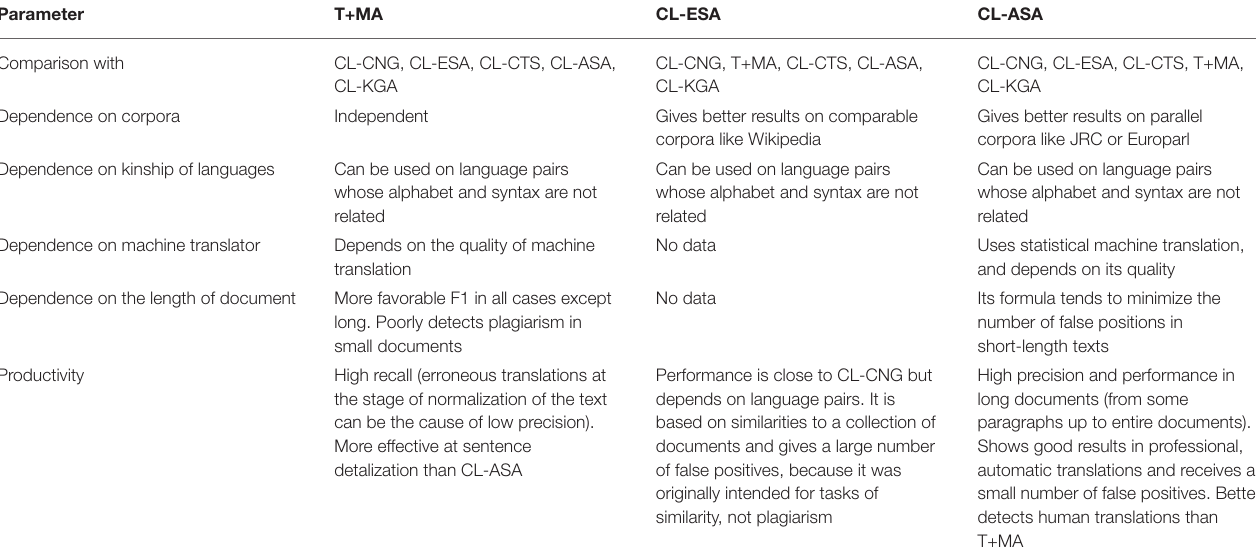
TABLE 1 | Comparative table of models T+MA, CL-ESA, CL-ASA.